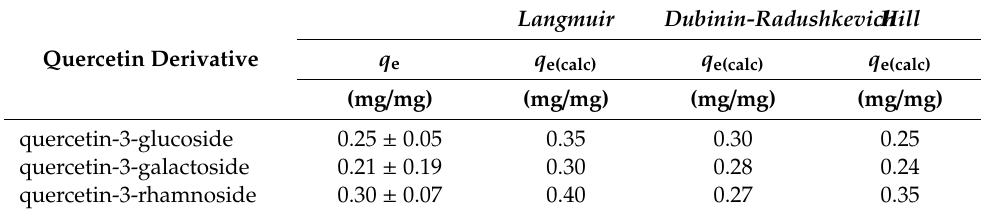
Table 2. Quercetin derivative adsorption capacities ( q e ) and adsorption capacities calculated from